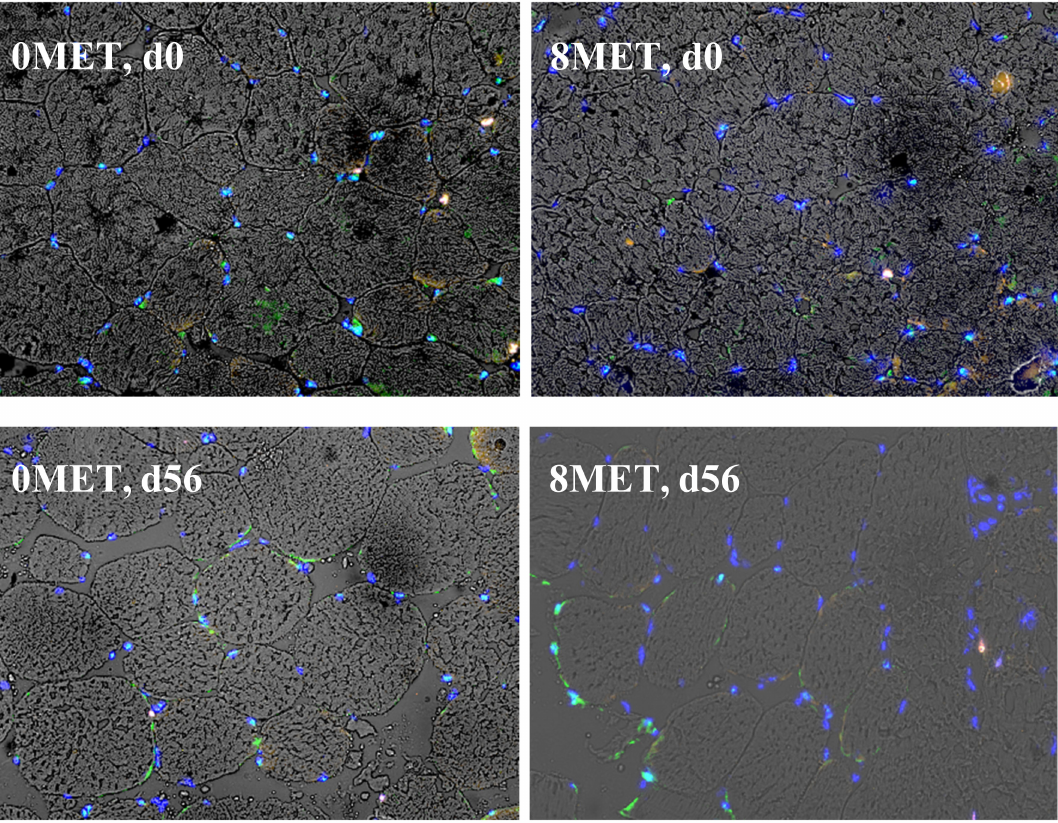
Figure 3. Immunohistochemical detection of satellite cells in longissimus tissue. Yellow = PAX7, green = Myf5, blue = nuclei. 0MET = 0 g encapsulated methionine and 4 g encapsulated lysine per hd/d, 8MET = 8 g encapsulated methionine and 4 g encapsulated lysine per